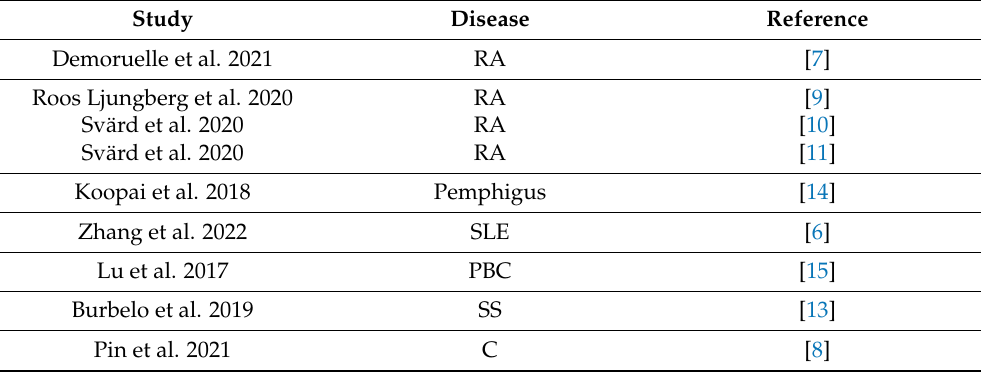
Table 4. Overview of studies on autoantibodies measured in saliva. Study